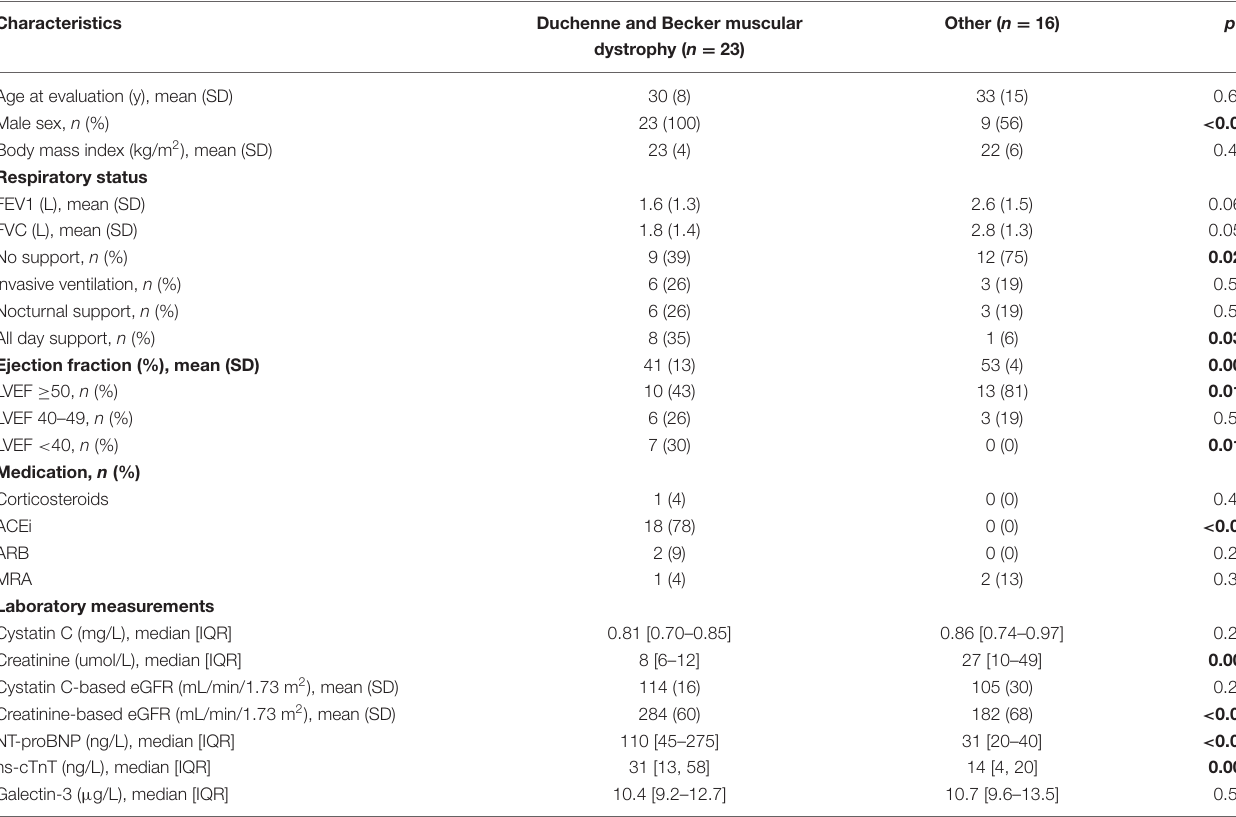
TABLE 2 | Baseline characteristics of Duchenne and becker muscular dystrophy patients and other neuromuscular dystrophy patients.